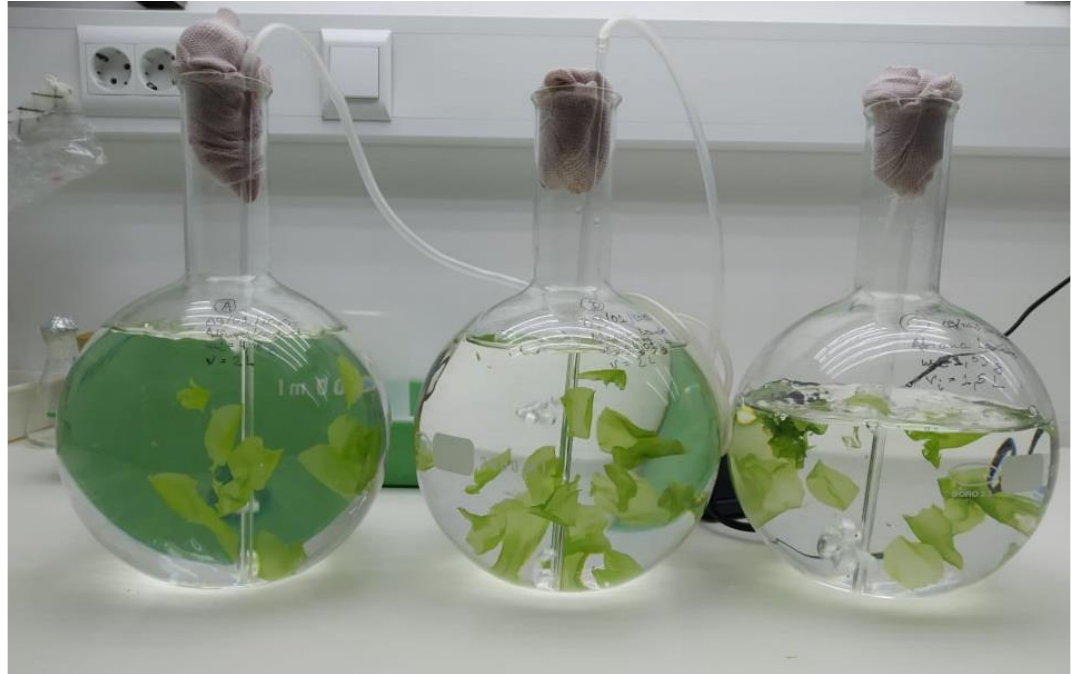
Figure 4. Seaweed juvenile cultivation for aquaculture upscaling.